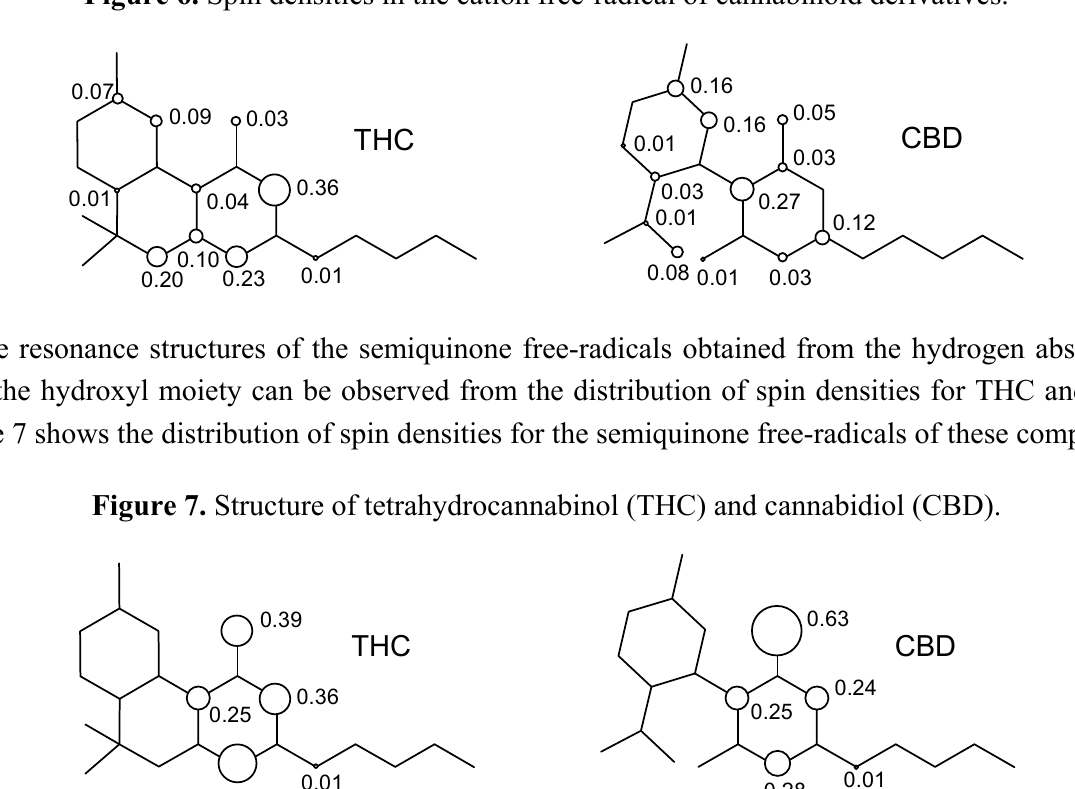
Figure 6. Spin densities in the cation free-radical of cannabinoid derivatives.